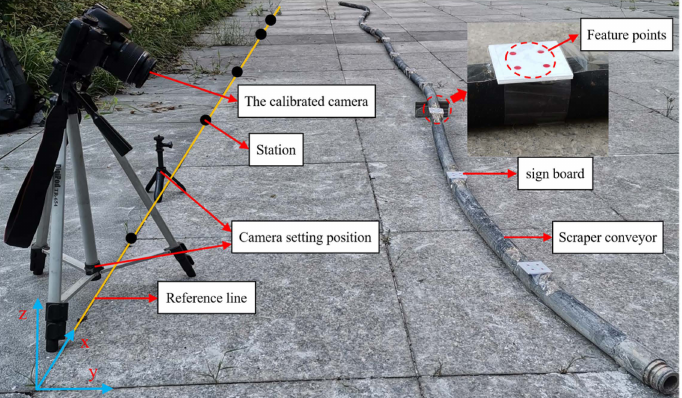
Figure 4. Scraper conveyor visual measurement experimental